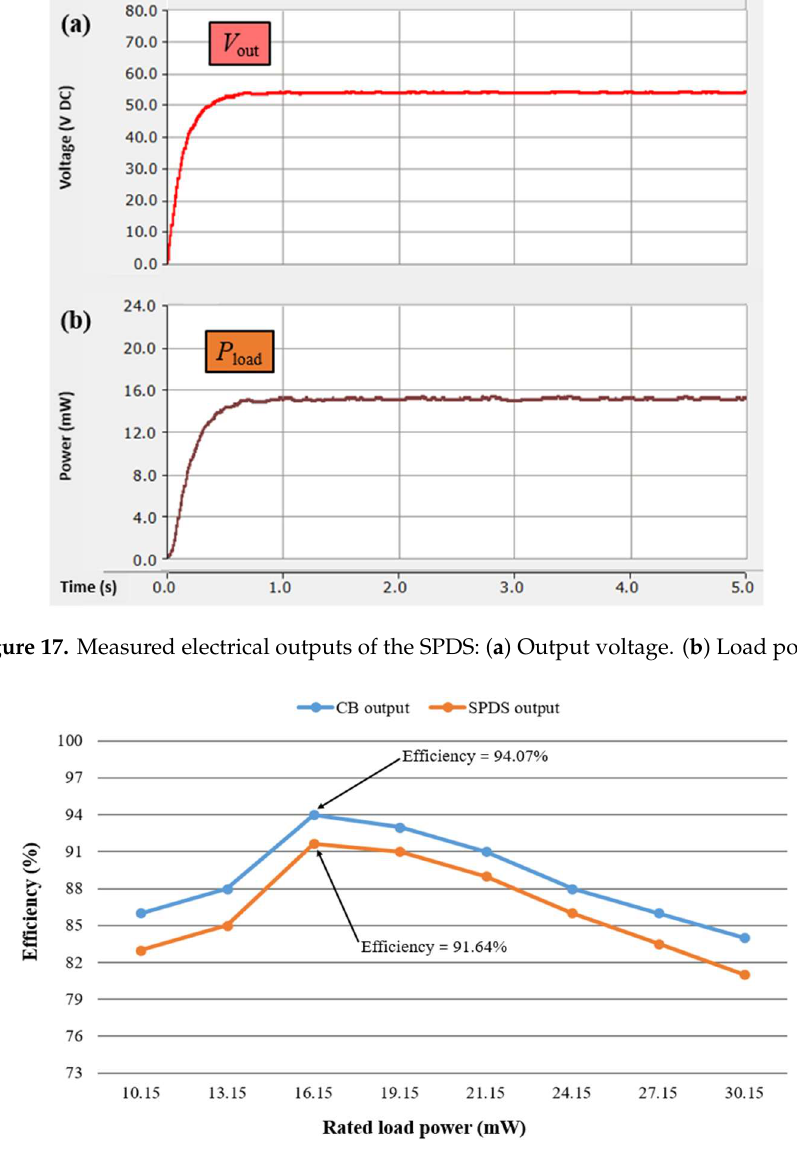
Figure 18. Computed efficiency versus rated power of different loads.